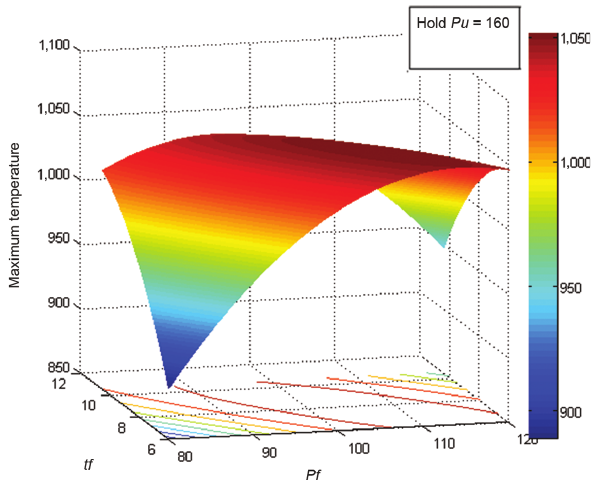
Figure 10: Surface plot of maximum temperature versus tf and Pf